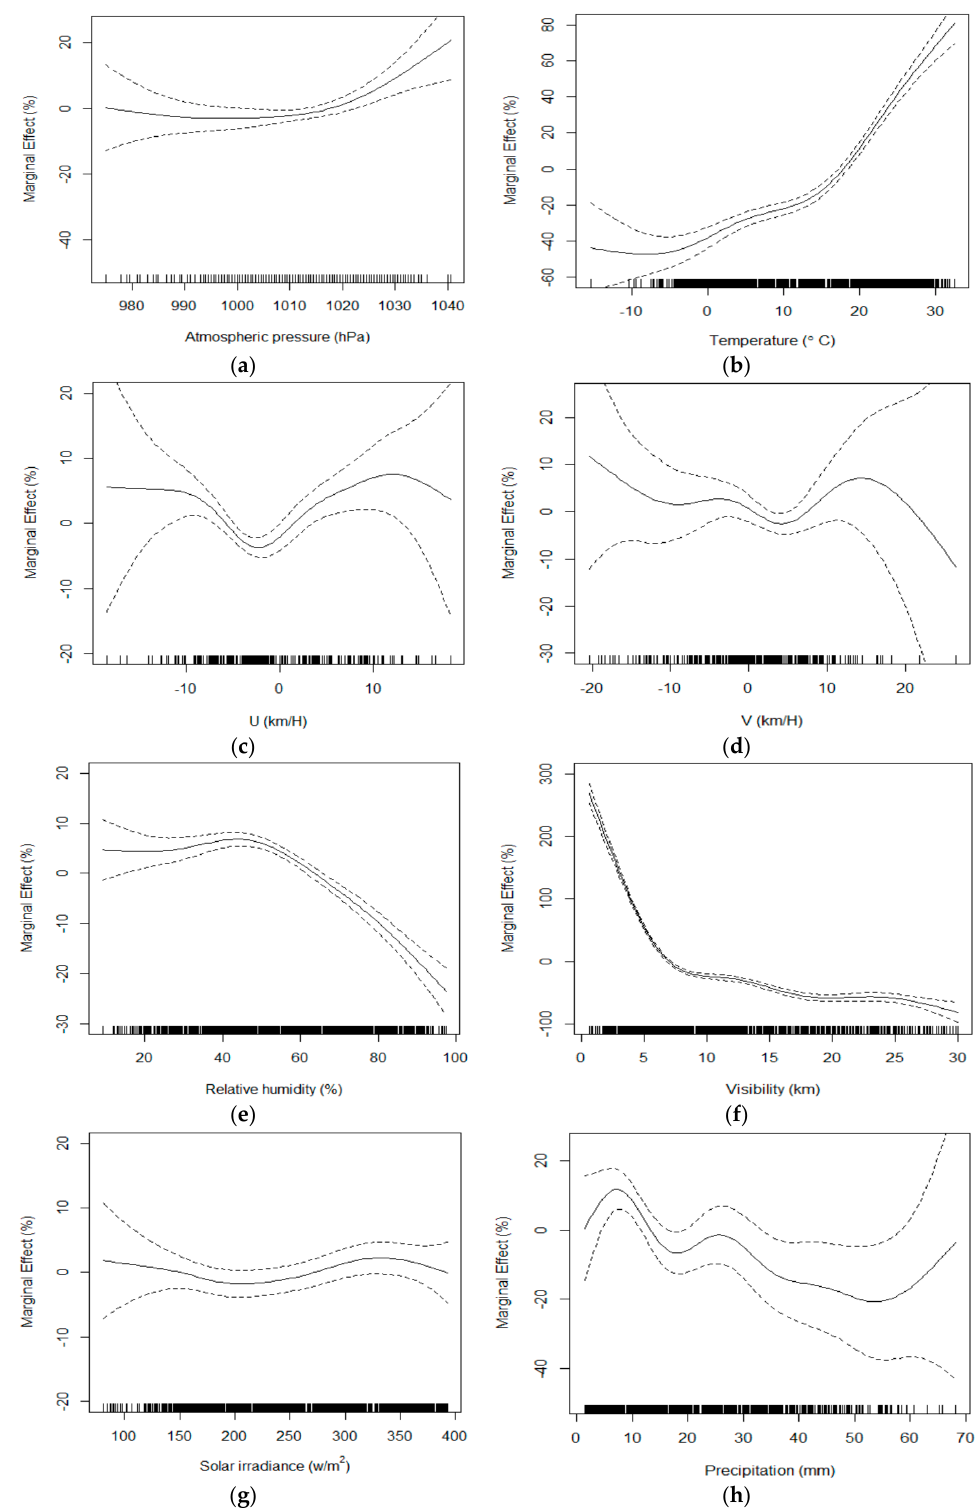
Figure 2. Partial residual plot for PM 2.5 . ( a ) atmospheric pressure; ( b ) temperature; ( c ) zonal ( u ) wind; ( d ) meridional ( v ) wind; ( e ) relative humidity; ( f ) visibility; ( g ) solar irradiance; ( h ) precipitation. The abscissa represents the magnitude of each meteorological variable. The ordinate represents the marginal effect, which is the impact of various meteorological variables on air pollutants. The dashed line is the 95% confidence interval and the short line perpendicular to the abscissa represents the distribution frequency of each meteorological